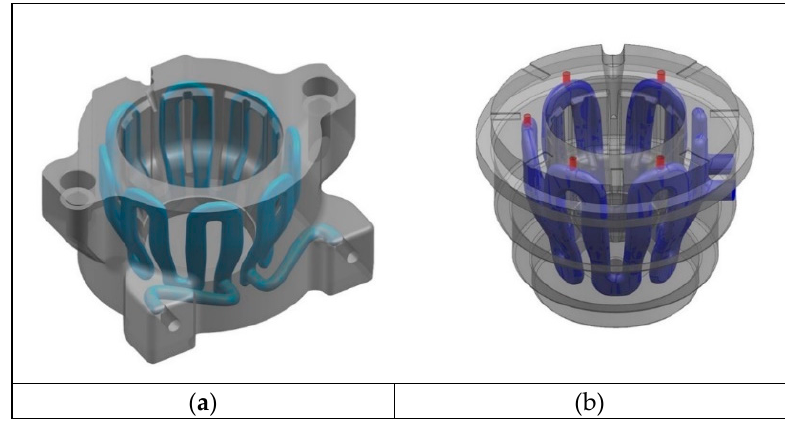
Figure 4. CAD geometry evolution of the mould insert designed with the aid of the CAD software NX Siemens: ( a ) first design iteration; ( b ) final CAD geometry including necessary details for SLM process feasibility.